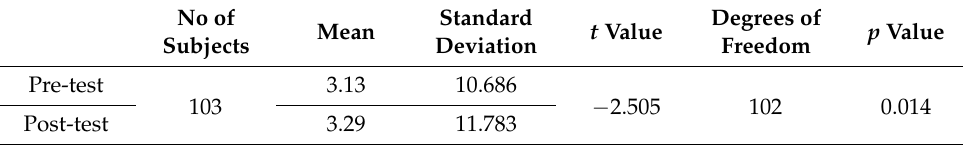
Table 6. Results of Independent Sample t -test on Students’ scientific attitude. No of Standard t Mean Subjects Deviation